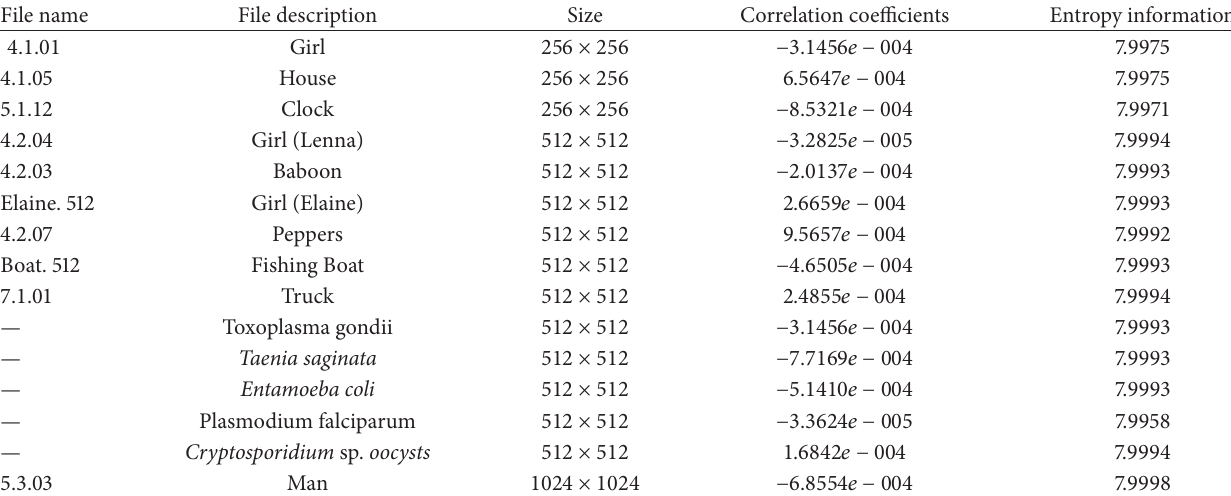
Table 2: Correlation coefficients and entropy information between the gray image and corresponding cipher image of several USC-SIPI